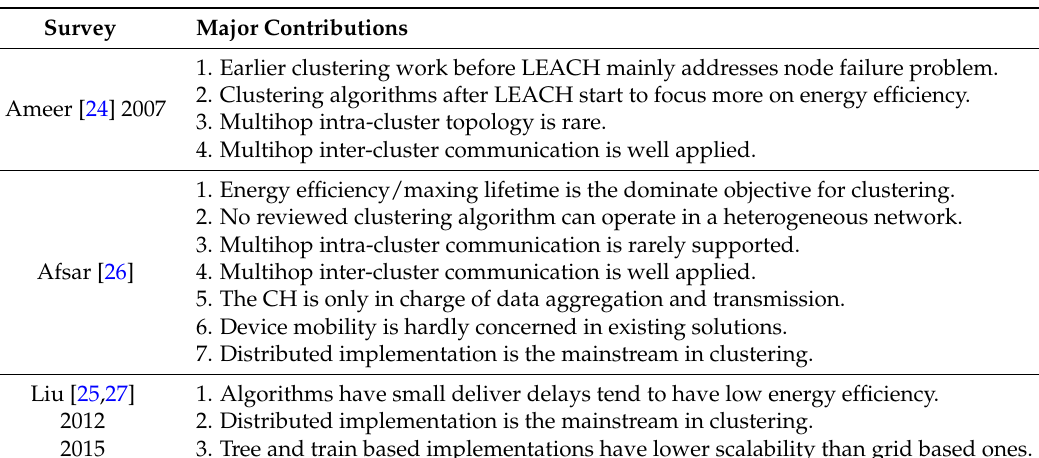
Table 2. Summaries for Selected Existing Survey Papers on Clustering for